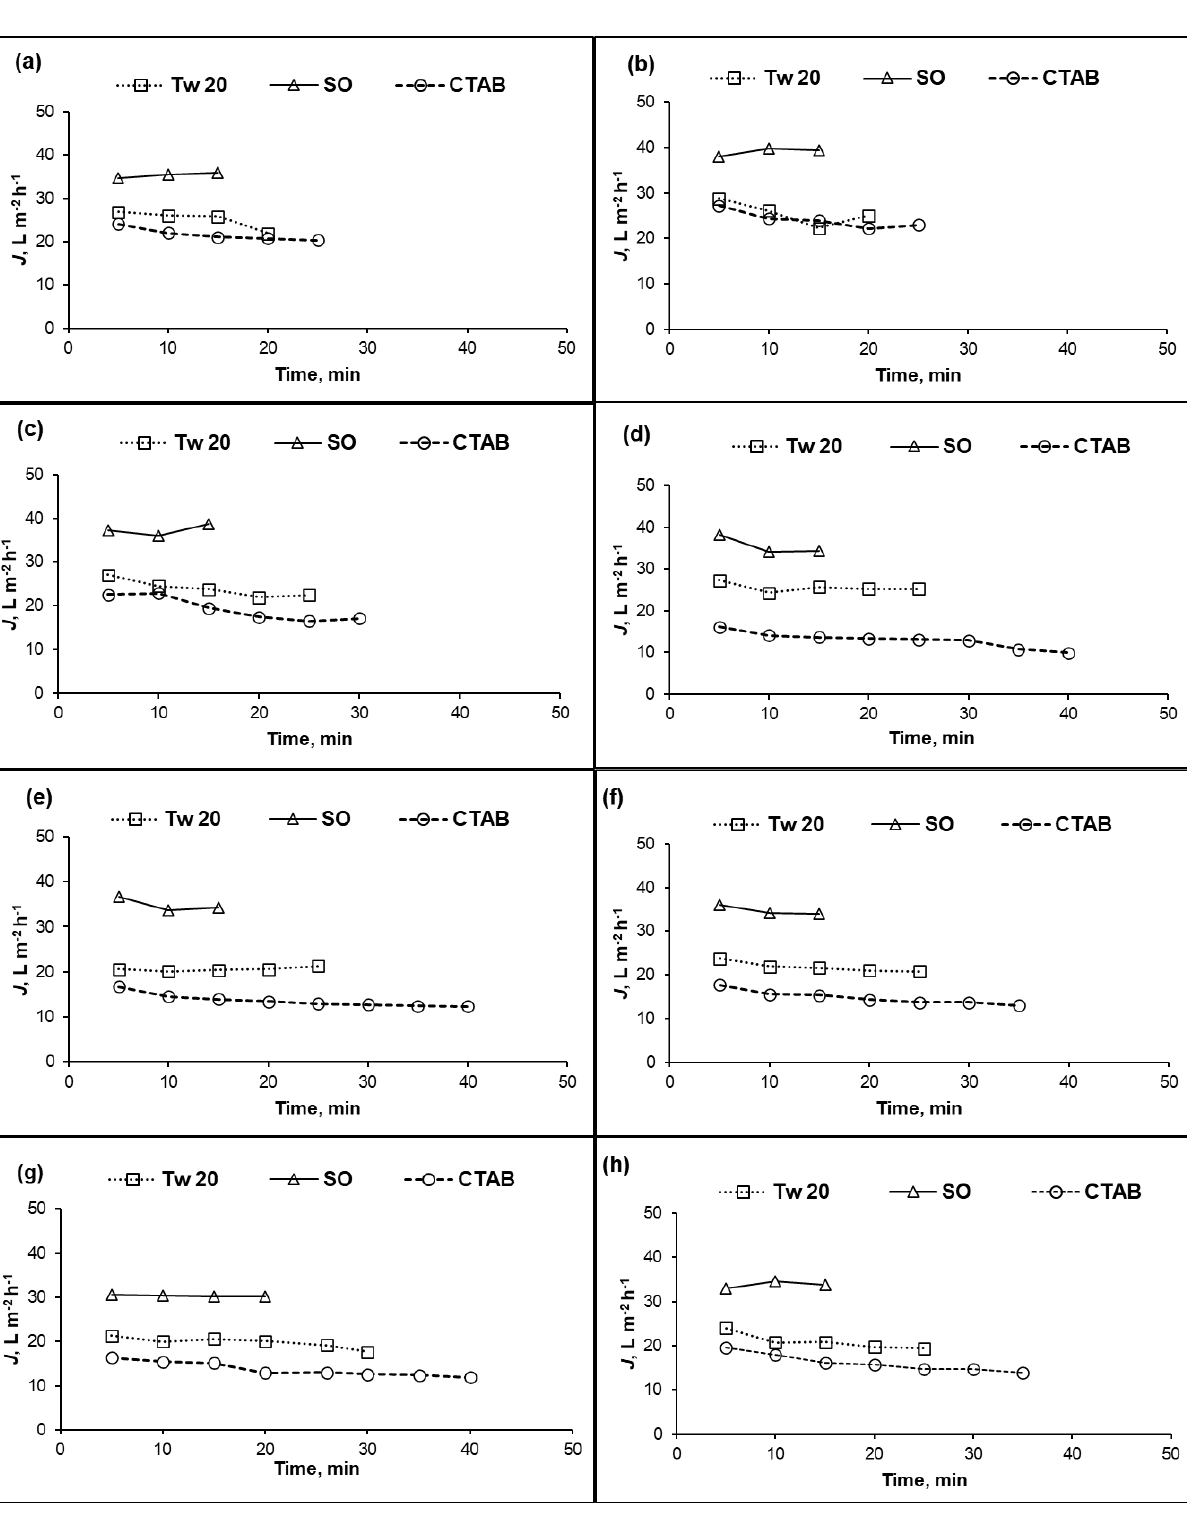
Figure 2. Permeate flux ( J ) of PA membrane versus time at different surfactant concentrations: ( a ) 10 mg/L; ( b ) 25 mg/L; ( c ) 50 mg/L; ( d ) 100 mg/L; ( e ) 250 mg/L; ( f ) 500 mg/L; ( g ) 1000 mg/L; and ( h ) 10,000 mg/L; (10% recovery ratio, operating pressure = 1.5 MPa, temperature = 25 °C).